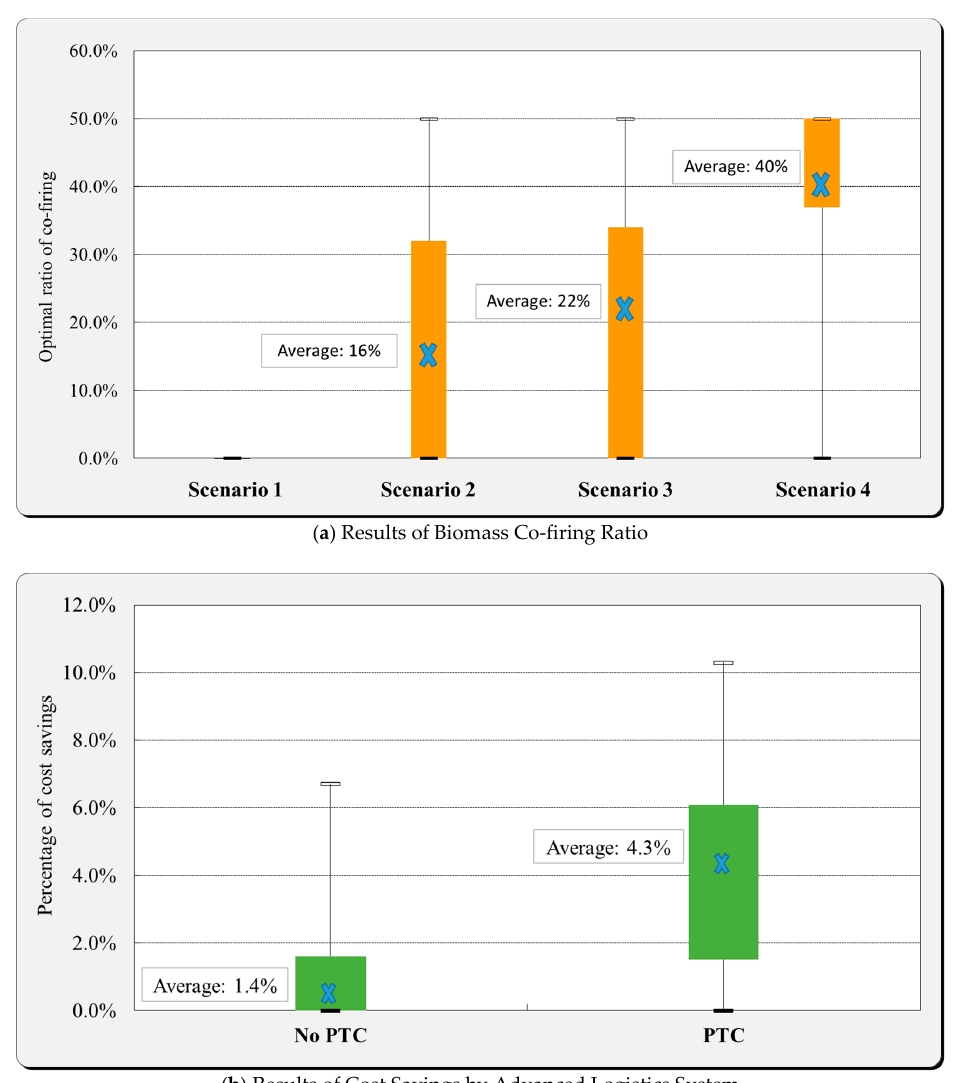
Figure 6. Biomass co-firing ratio and cost savings by changing logistics system. ( a ) Results of Biomass Co-firing Ratio; ( b ) Results of Cost Savings by Advanced Logistics System. PTC, production tax credit.